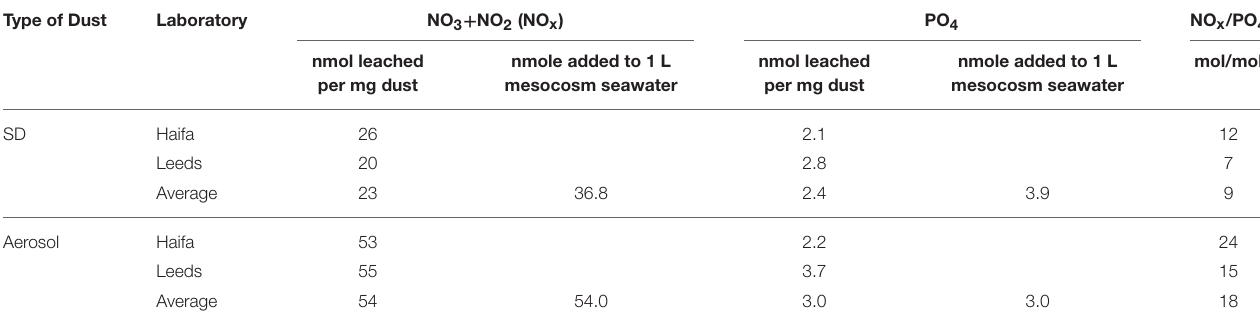
TABLE 3 | Summary of the leached NO x and PO 4 from the SD and A treatments. Type of Dust